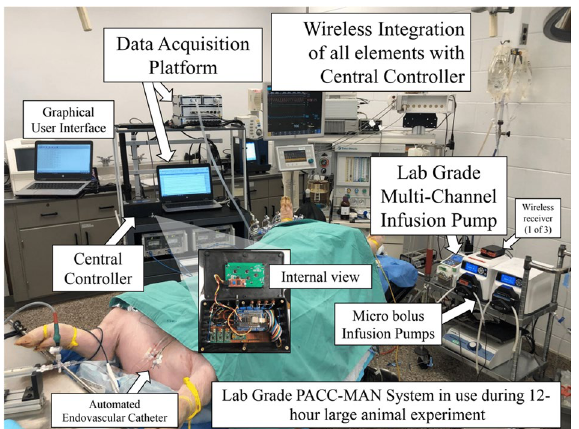
Fig. 2 A picture of the setup in use for a critical care experiment. Data Acquisition platform (Powerlab, AD Instruments, Colorado Springs, CO, USA), Central Controlled (Arduino, Arduino LLC, Boston, MA, USA), Wixel Wireless Transceiver, Pololu Corporation, Las Vegas Nevada (Wireless receiver), Lab Grade multi‑channel infusion pump (Isamatec, Cole‑Palmer an Antylia Scientific Company, Vernon Hills, IL, USA), and Micro bolus Infusion Pump (Masterflex an Antylia Scientific Company, Antylia Scientific, Vernon Hills, IL,